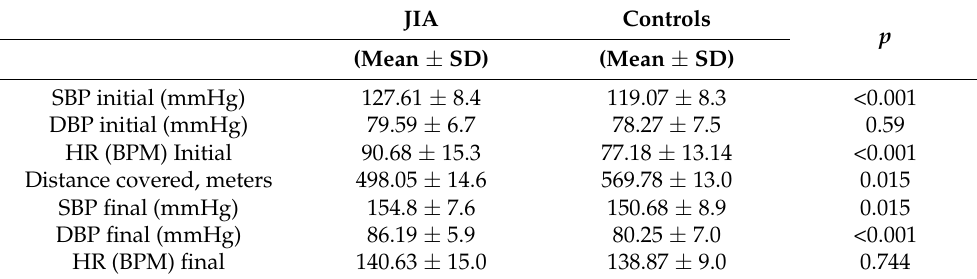
Table 3. Comparison between the means of the 6-minute walk test (6MWT).